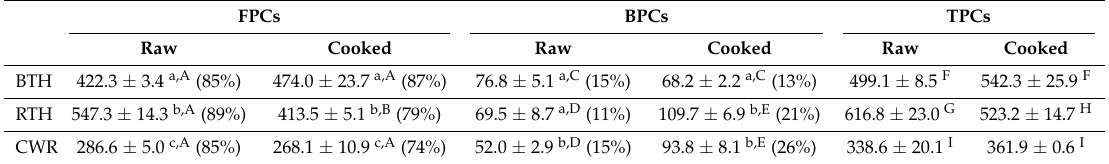
Table 3. FPC, BPC and TPC content (mg GAE/100 g d.m.) in raw and cooked Thai and wild rice samples. FPCs BPCs TPCs Raw Cooked Raw Cooked Raw Cooked BTH 422.3 ± 3.4 a,A